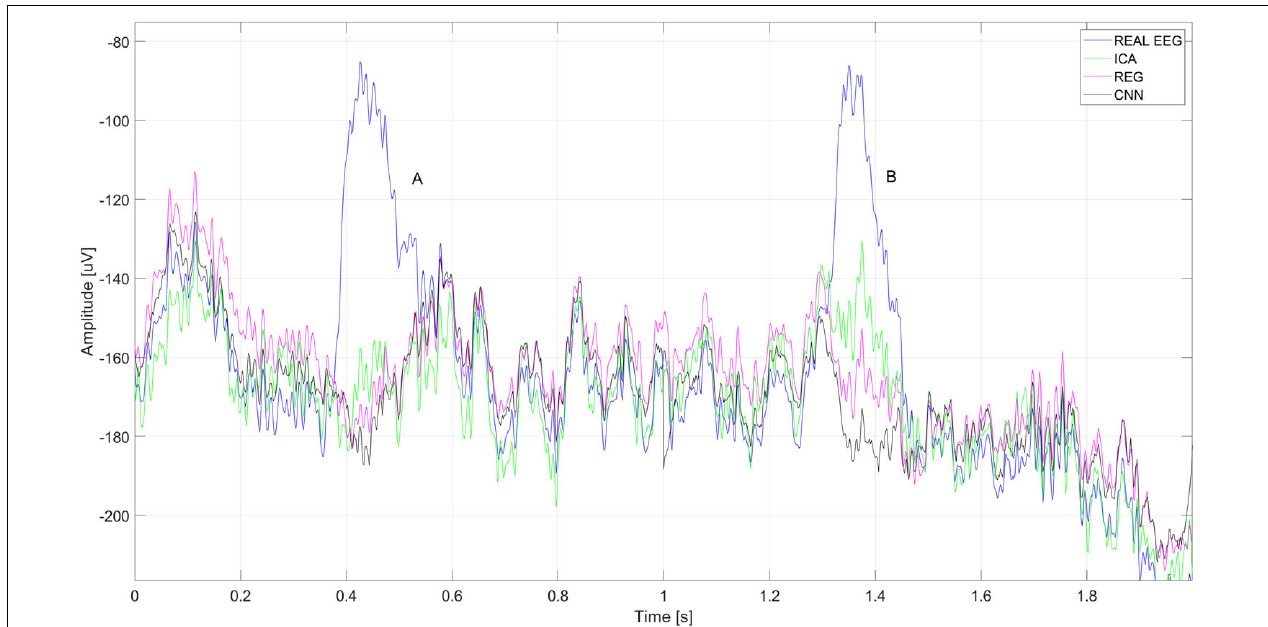
FIGURE 20 | A fragment of the EEG signal recorded for the Cz electrode. The letters A and B represent the times when the blink artifact occurred.